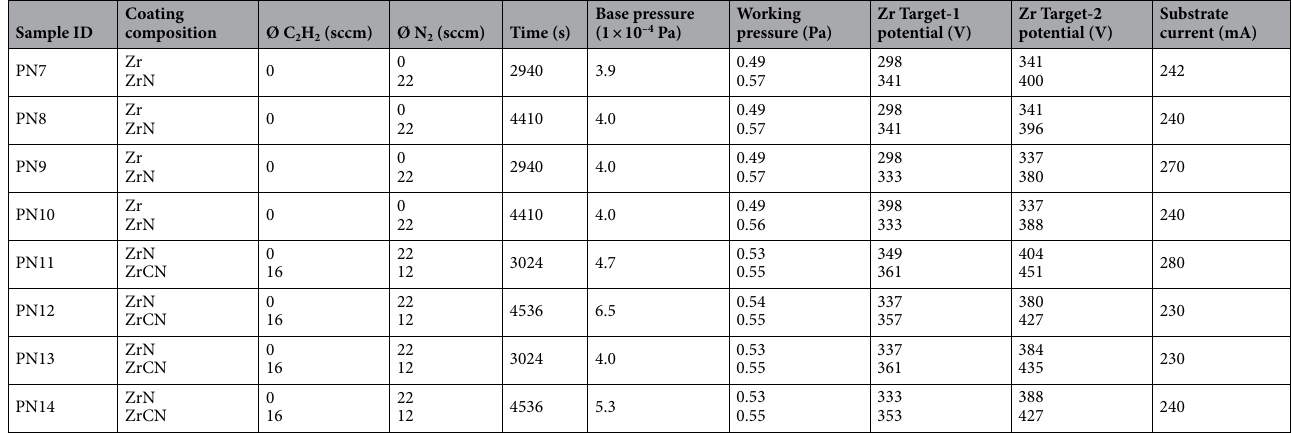
Table 1. Films deposition conditions.